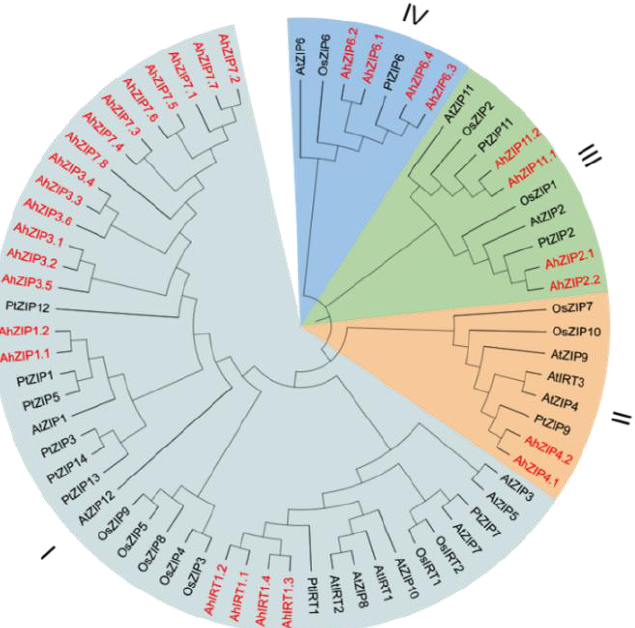
Figure 1. Phylogenetic relationships of ZIP proteins in peanut and other plant species. The species involved in the evolutionary tree include peanut (AhZIP), Arabidopsis thaliana (AtZIP), Oryza sativa (OsZIP), and Poncirus trifoliata (PtZIP). The 30 AhZIP proteins of peanut are marked in red.